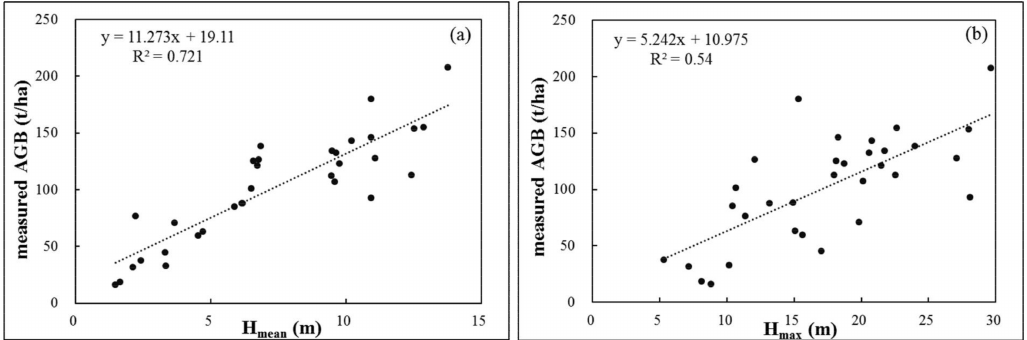
Figure 6. Measured aboveground biomass versus the mean ( a ) and the max ( b ) of tree height in the sample